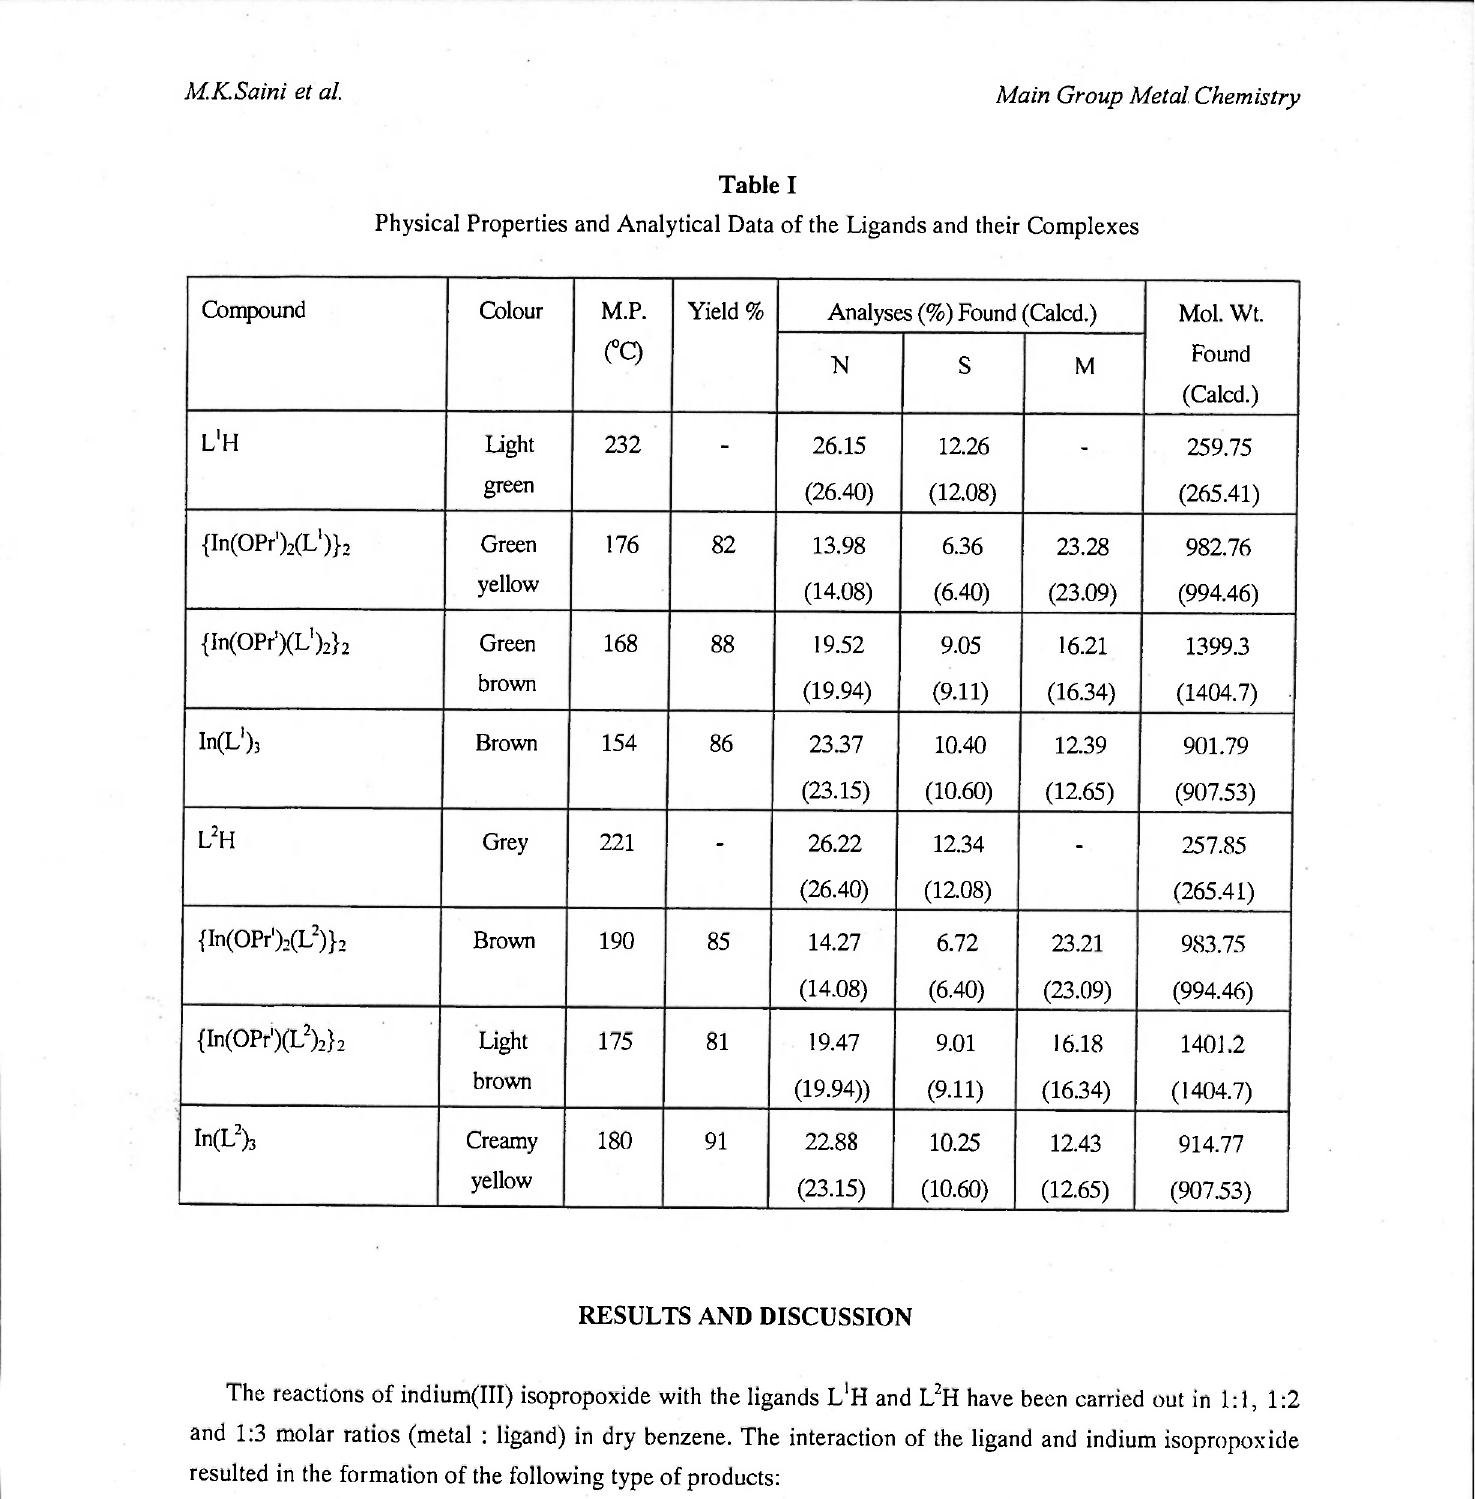
Physical Properties and Analytical Data of the Ligands and their Complexes